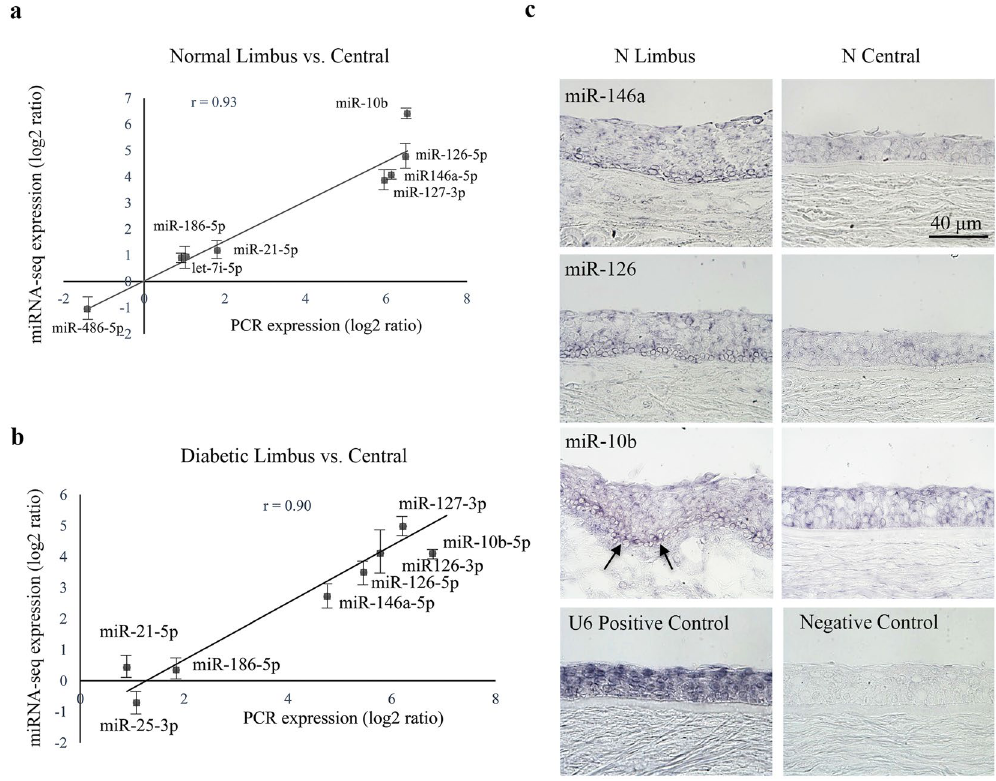
Figure 3. Validation of deep sequencing data of differentially expressed limbus vs. central corneal miRNAs. ( a , b ) Quantitative RT-PCR validation of deep sequencing data, limbus vs. central cornea. Several miRNAs are differentially expressed in limbus vs. central cornea. There was a strong concordance between QRT-PCR and deep sequencing data on differentially expressed limbal vs. central miRNAs in normal (( a ) correlation r = 0.93) and diabetic (( b ) correlation r = 0.90) samples, Each sample was run in triplicate. ( c ) In situ hybridization with locked nucleic acid (LNA) modified probes, miR-146a, miR-126 and miR-10b, was performed on sections of normal corneas, compared to scrambled sequences. The miRNA signals are stronger in the limbus than in the central cornea and more expressed in the basal cell layer in limbal epithelium (arrows). U6 miRNA probe and scrambled sequences were used as positive and negative controls, respectively. Bar = 60 μ